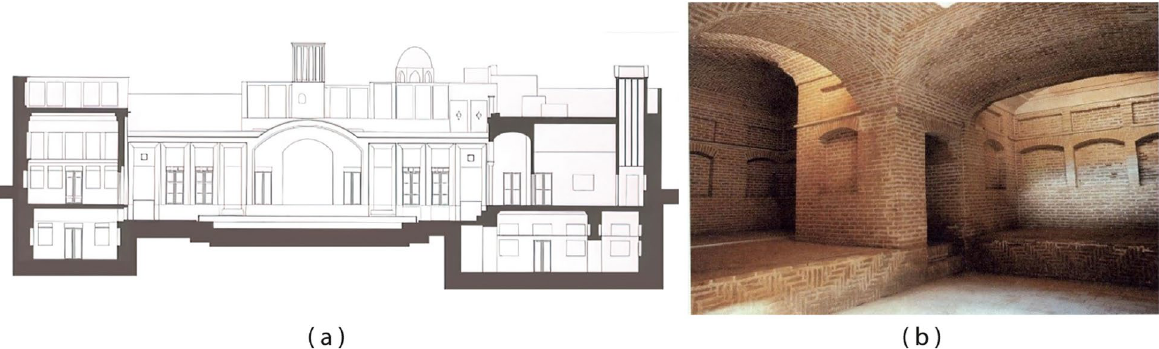
Fig. 4 Cellar in the Akhavan‑sigari house, Yazd: ( a ) cross‑sectional elevation view and ( b ) view of southwestern cellar (Source: Haji‑Qassemi and Khoei 2004)